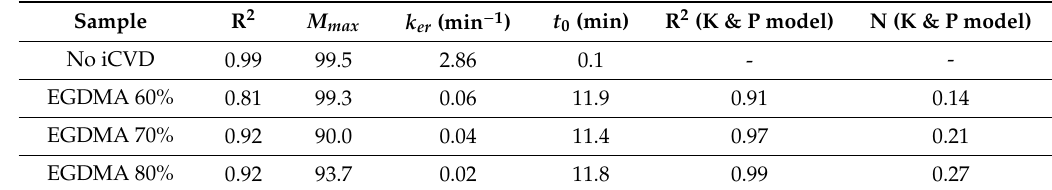
Figure 4. ( a ) Percentage of released gentamicin from spin coated samples ([Gent] = 100 mg/mL, v = 1500 rpm) without iCVD coating and coated with a 200 nm iCVD layer with different EGDMA volume fractions: 60%, 70% and 85%. Average values obtained measuring the conductivity of three replicates, a maximum standard deviation of 12% was estimated for each data point. Total content of gentamicin is 45 ± 5 µg/cm 2 . ( b ) Gentamicin release data for the 85% EGDMA polymer coating fitted with the exponential model of Equation (1) and with the Korsmeyer and Peppas model. Table 1. Fitting results of the release data. The first four parameters refer to the model of Equation (1). The last two to the Korsmeyer and Peppas model.